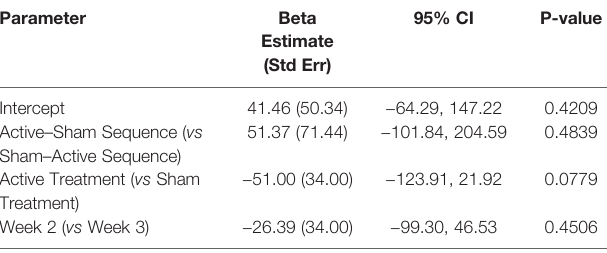
FIGURE 4 | Comparison of the baseline Hamilton Depression Rating Scales with those one week after the active and the sham treatments. The differences between the scores after the active [8.8 (SD 10.3)] and sham treatments [13.3 (SD 12.9)] were signi fi cant by a one-sided, Wilcoxon Test, **p = 0.0053. TABLE 7A | Summary of Mixed Model for Percent Change in Mean HARS.